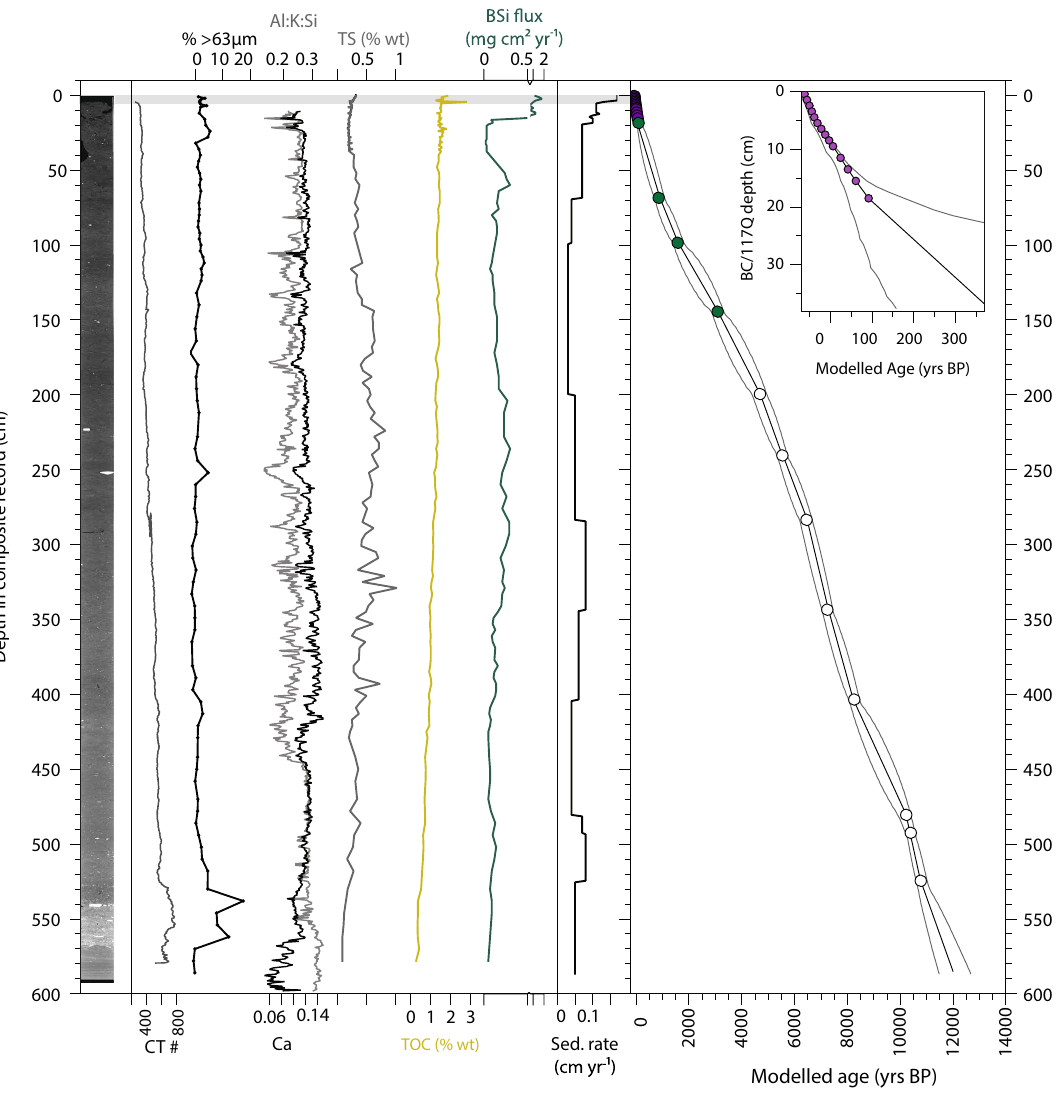
Figure 3. Physical and selected biogeochemical sediment properties and age-depth model for 117Q BC and 117Q. From left to right: 117Q Computerised tomography (CT) scan image and CT number (#). Denser areas appear whiter in the CT scan image. The sand fraction (% > 63 µm) measured by wet sieving (black). Variations in XRF-measured elements calcium (Ca; black) and sum of Al, K and Si (grey), both are shown as ratio to the sum of total elemental counts. Percentage (weight) of total sulphur (TS; grey) and total organic carbon (TOC; yellow) and biogenic silica fluxes (BSi; dark green). Calculated sedimentation rates (cm yr -1 ) are shown in black. The median age (modelled) -depth relationship constructed in BACON for 117Q and 117Q BC (insert) are shown with purple-filled circles representing 210 Pb-dated intervals, green-filled circles indicating the bulk organic carbon 14 C-dated intervals and open circles the 14 C-dated intervals (biogenic carbonate). The solid black line indicates the median modelled age-depth relationship and the grey dashed lines indicate maximum and minimum modelled ages in the 95% confidence interval. The grey bar indicates the stratigraphic interval where 117Q BC and 117Q proxy data